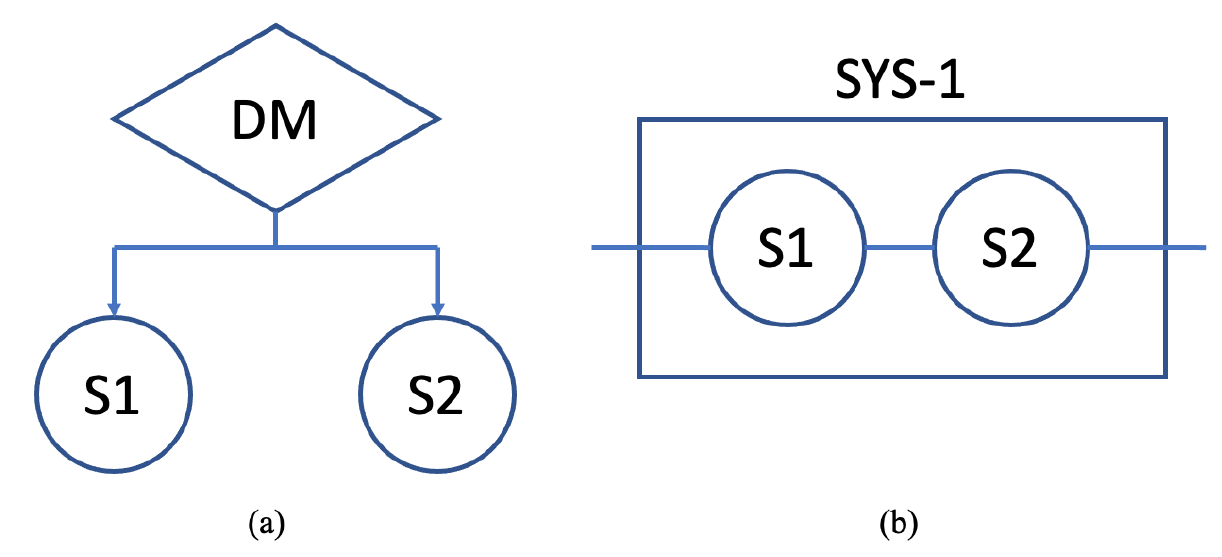
Figure 4. Sample system (System-1) with one decision maker (DM) and two sensors, S1 and S2. ( a ) System diagram as DM relies on S1 and S2. ( b ) Logic representation where the sensors are connected in